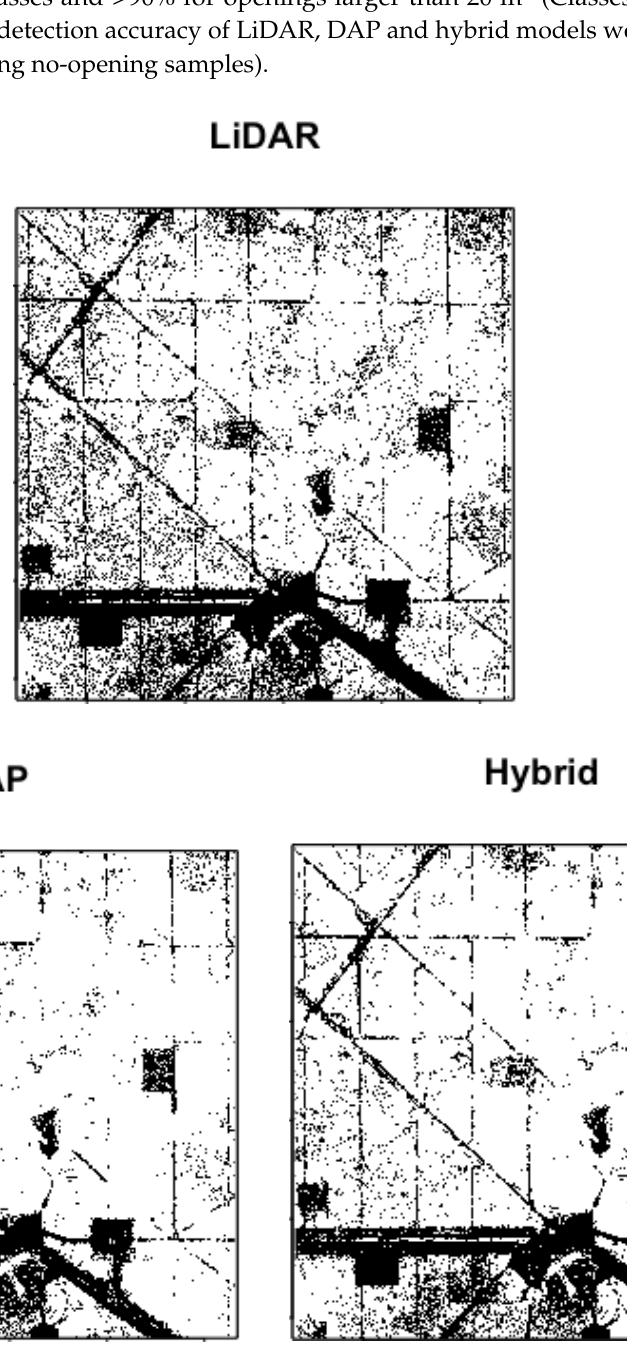
Figure 5. Maps showing canopy opening delineations for each approach. Openings are depicted in black, areas classified as no-openings are depicted in white. Opening delineations were derived from CHM LiDAR ( top ), CHM DAP ( lower left ), and CHM Hybrid ( lower right ).